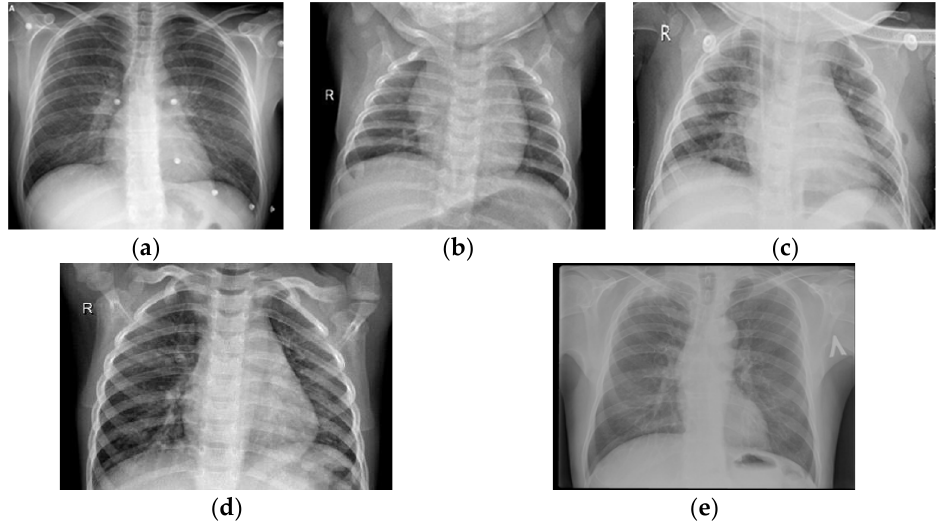
Figure 2. Sample display of each class: ( a ) COVID-19; ( b ) normal; ( c ) bacterial pneumonia; ( d ) viral pneumonia; ( e ) tuberculosis.